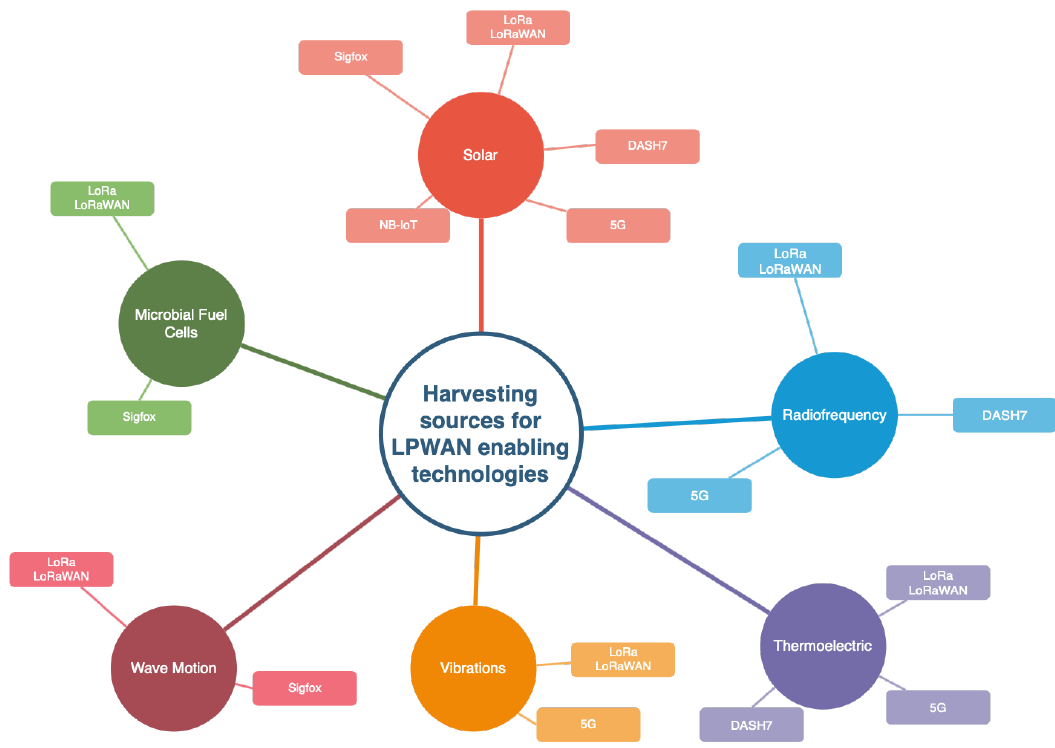
Figure 1. Harvesting sources for LPWAN enabling